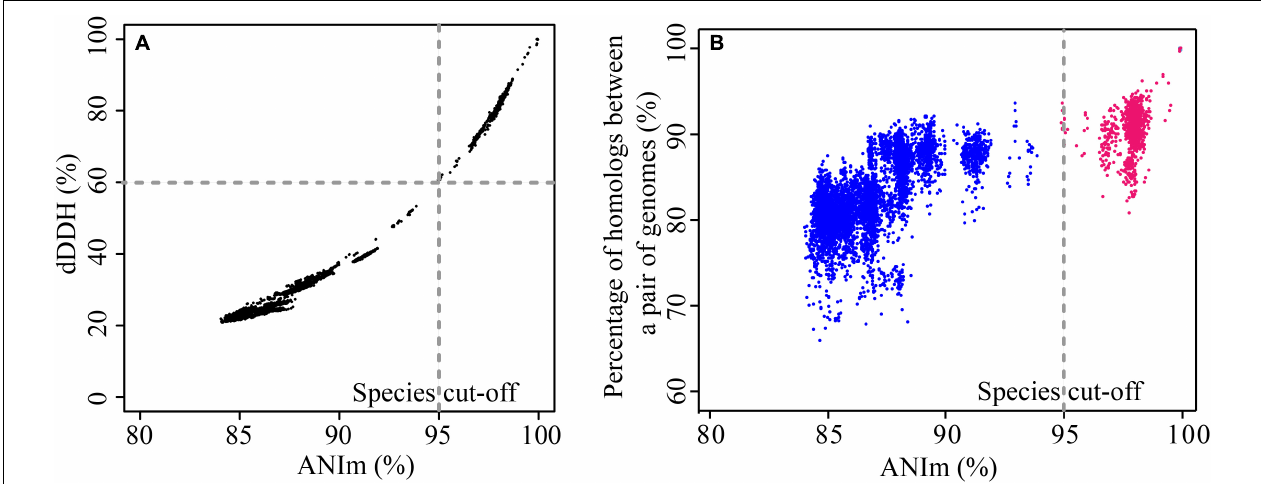
FIGURE 1 | Comparison of similarities and diversities for 123 P. stutzeri group genomes. (A) Correlation between ANI and dDDH. Each data point represents the dDDH value between two strains against their corresponding ANIm value. The two approaches revealed a significant correlation, with an r 2 of 0.986. (B) Correlation between conserved genes and evolutionary distance for bacterial species. Each data point represents the percentage of homologous genes between two strains plotted against their evolutionary distance, measured as dDDH between the strains. Red points denote pairs of strains that belong to the same genomovar, and blue points denote pairs of strains belonging to different genomovars, according to the species definition standard in this study. Although there is significant correlation, with an r 2 of 0.738, the pairwise percentage similarities of homologs are discordant with the genome